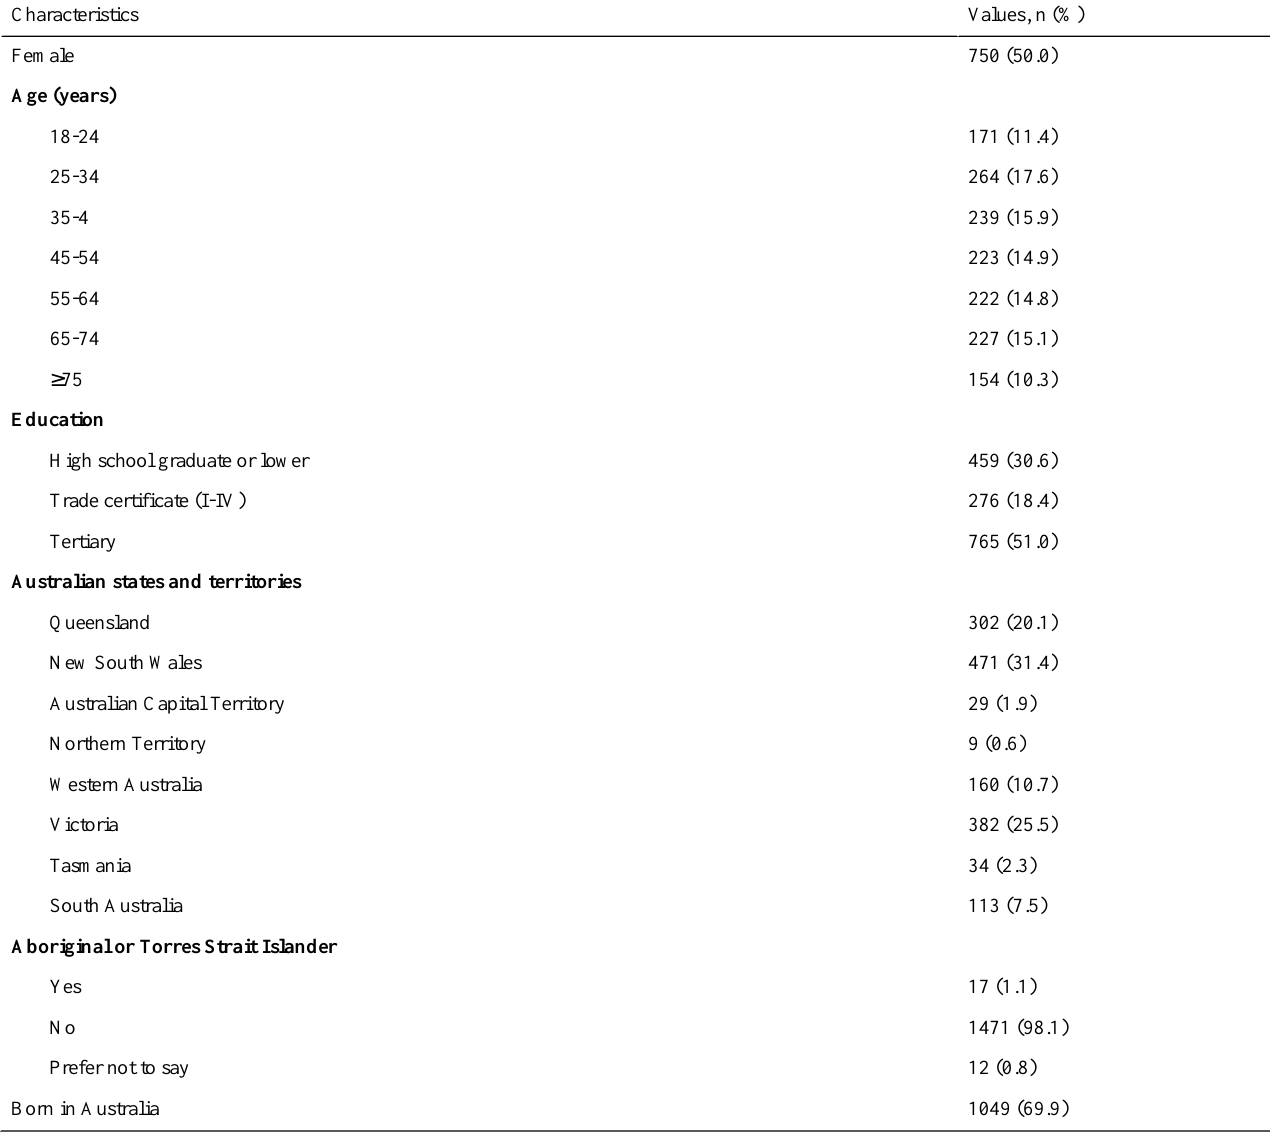
Table 1. Participants’characteristics (N=1500).